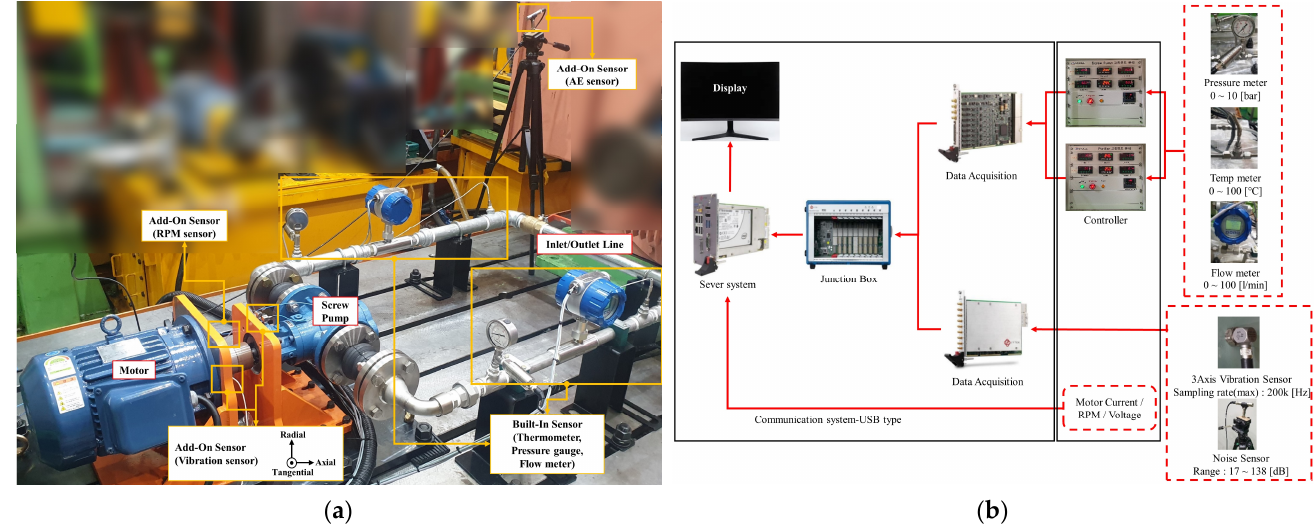
Figure 2. A land-based testbed for the fault simulation test: ( a ) Testbed facility picture; ( b ) Multi- parameter monitoring system.